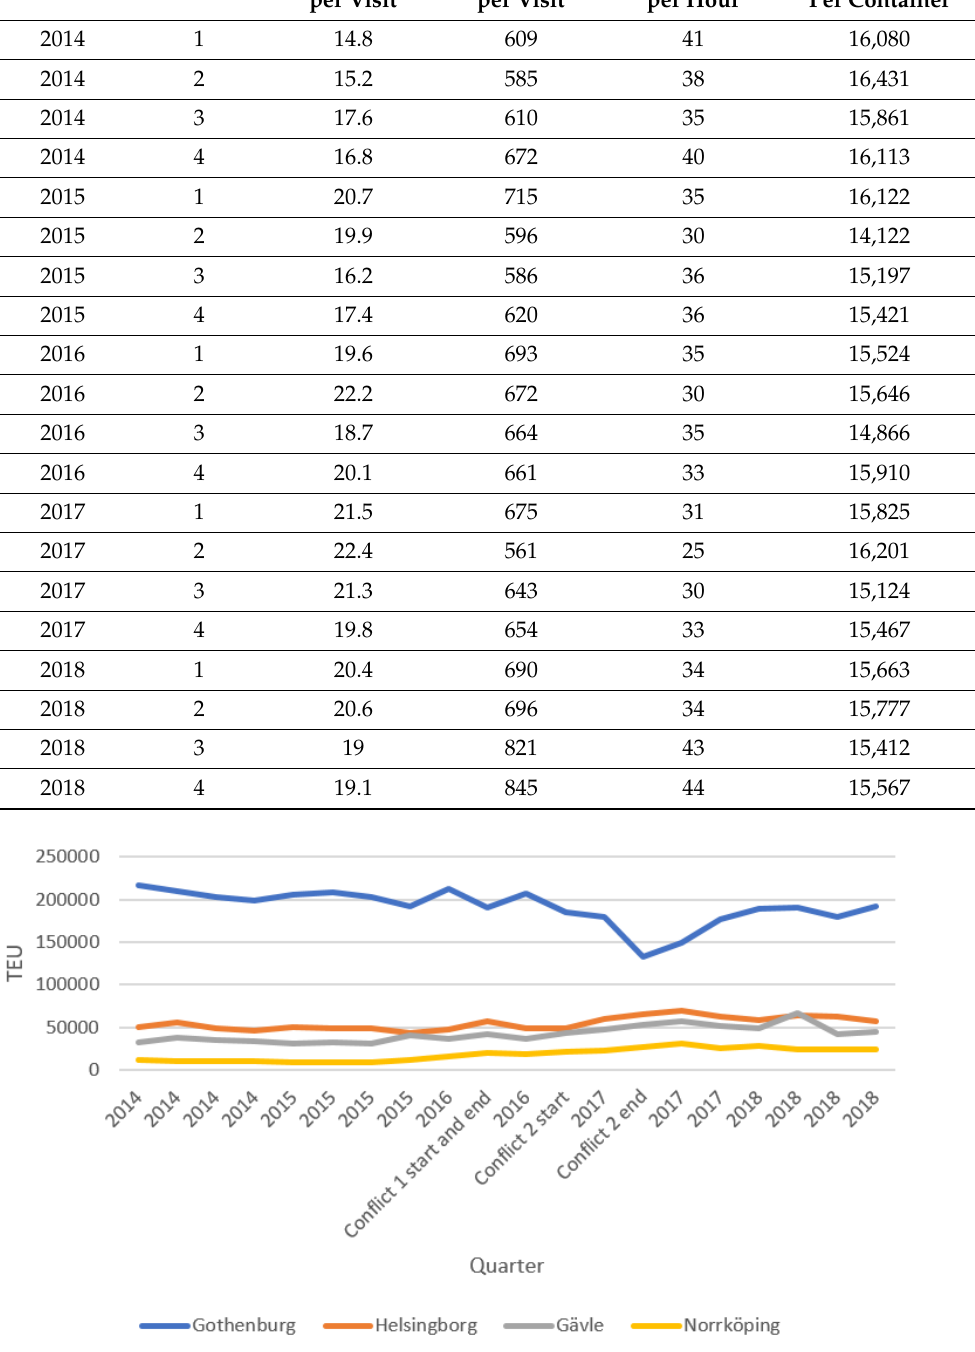
Figure 2. Number of TEUs Handled in the Four Ports.